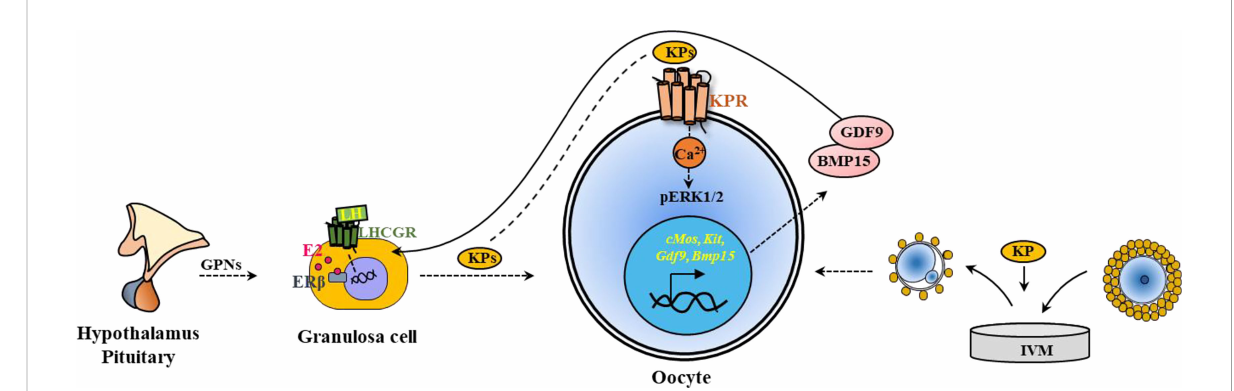
FIGURE 6 Kisspeptin induced in vivo and in vitro maturation of oocytes. Kisspeptins (KPs) mediate the maturation of ovarian follicles acting through hypothalamic-pituitary induction of gonadotropins (GPNs). GPNs act on granulosa cells and induce KP expression in the ovary. KPs can also act on the KPRs in the oocytes to induce oocyte maturation. Based on this strategy, KPs are included in the in vitro maturation (IVM) media to induce Ca 2+ release and activate ERK1/2 in the oocytes. During IVM, KPs also upregulate the expression of oocyte genes like cMos, Kit, Gdf9 and Bmp15 , which improve oocyte